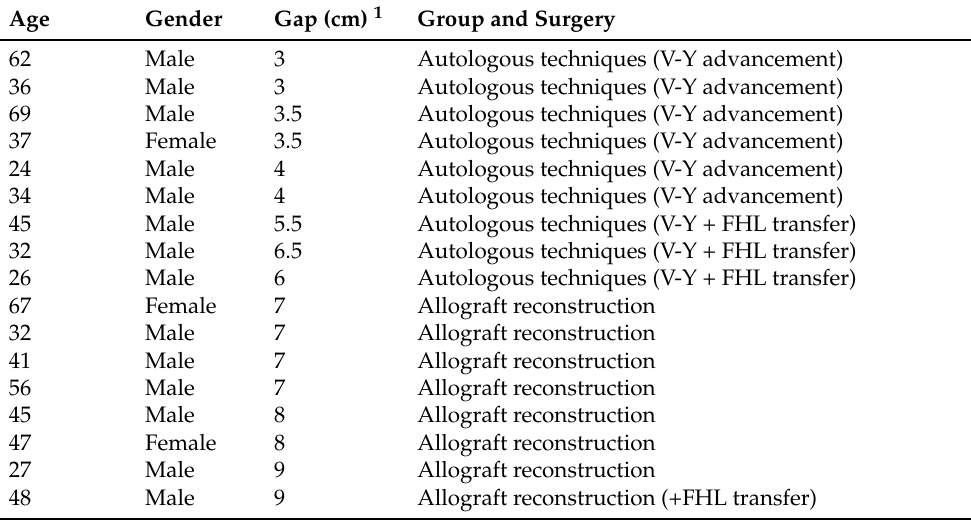
Table 1. Subgroup data with intraoperative gap and type of surgery performed in each